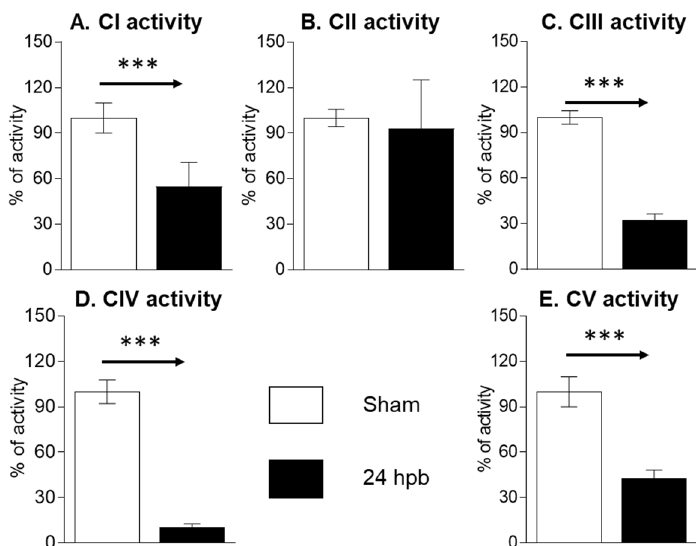
Figure 2. Cardiac mitochondrial electron transport chain activity in sham ( n = 9) and burn groups ( n = 9): ( A ) complex I; ( B ) complex II; ( C ) complex III; ( D ) complex IV; and ( E ) complex V are shown. Data are triplicated ( n = 9) and plotted as the mean ± SD. Significance is denoted as follows: * ( p < 0.05), ** ( p < 0.01), *** ( p < 0.001).